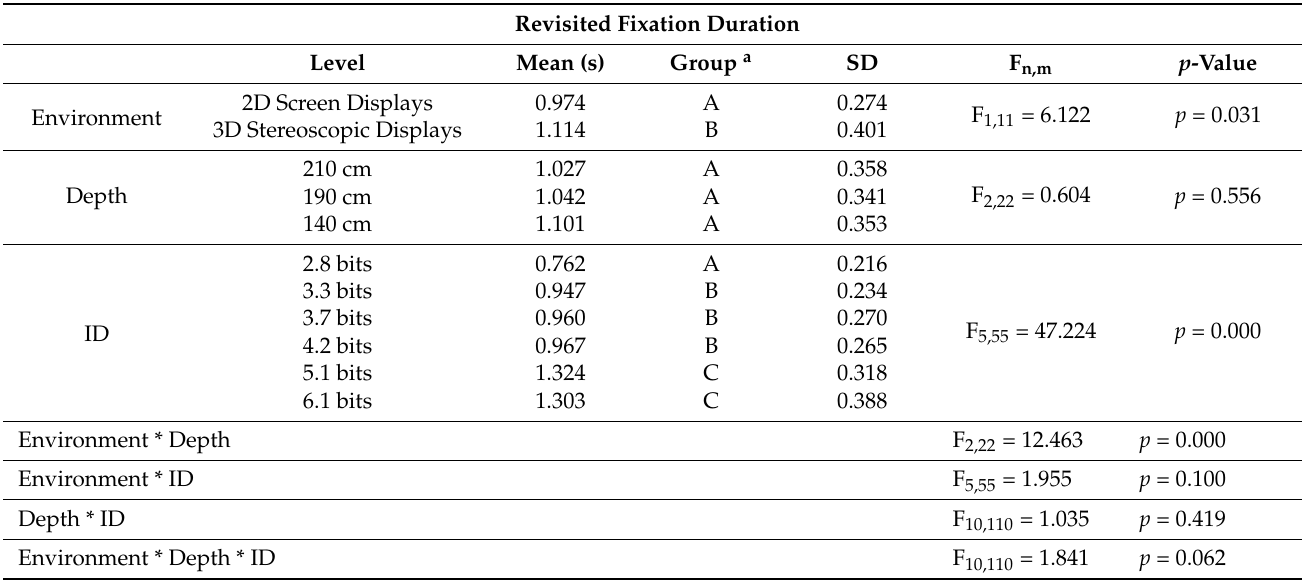
Table 8. Means, SDs, ANOVA, and Tukey HSD test results of revisited fixation duration.